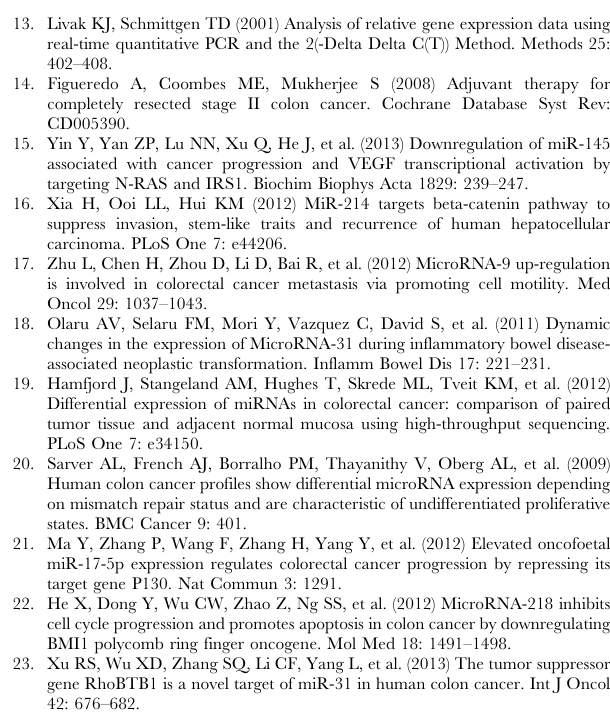
Table S1 Dysregulated miRNAs in CRC tissues com- pared with normal group with paired t-test. (XLSX) Table S2 Dysregulated miRNAs in CRC tissues com- pared with normal group with non-paired t-test. (XLSX) Table S3 Dysregulated miRNAs in CRC tissues com- pared with normal group in stage II with paired t-test. (XLSX) Table S4 Dysregulated miRNAs in CRC tissues com- pared with normal group in stage III with paired t-test. (XLSX) Table S5 Dysregulated miRNAs in CRC tissues com- pared with normal group in stage IV with paired t-test.